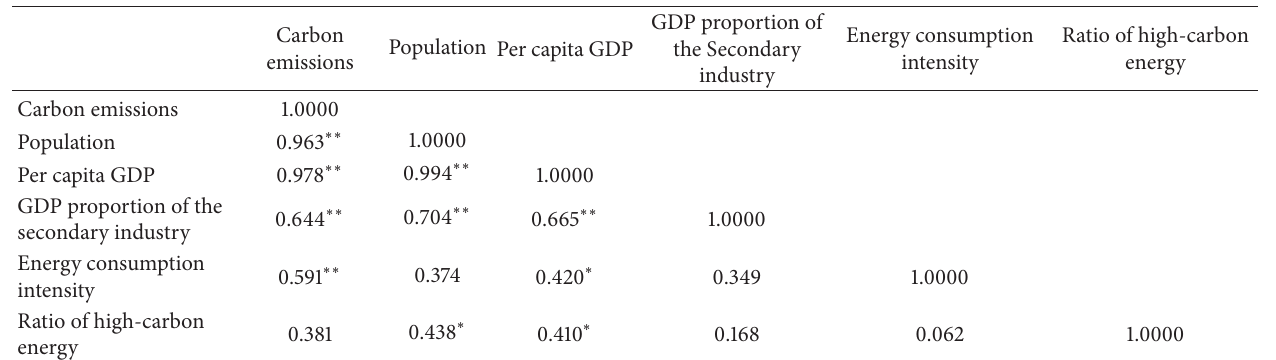
Table 6: Bivariate-Pearson correlation coefficients.